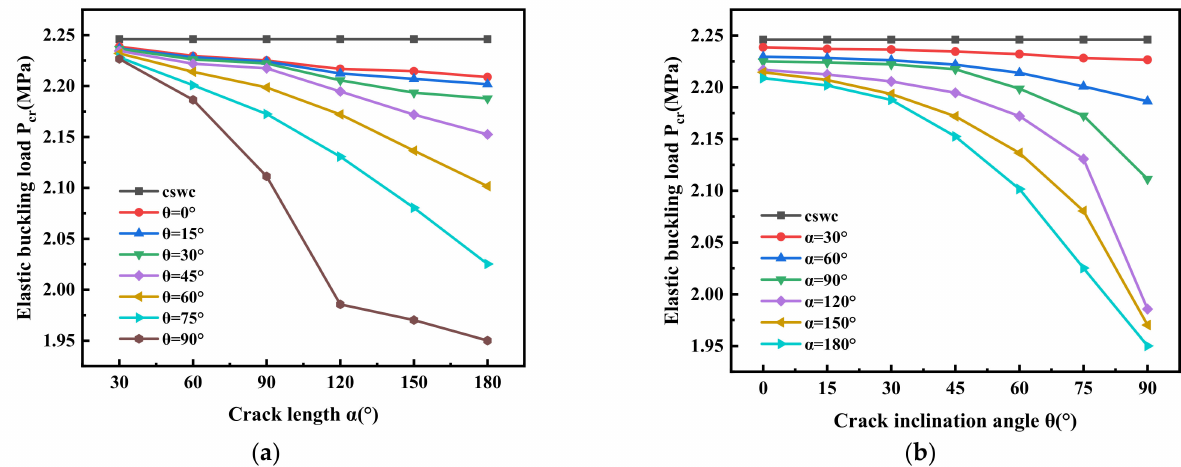
Figure 8. Relation between crack length and elastic buckling load with simple support at both ends of cylinder ( a ) Different crack lengths; ( b ) Different crack inclination